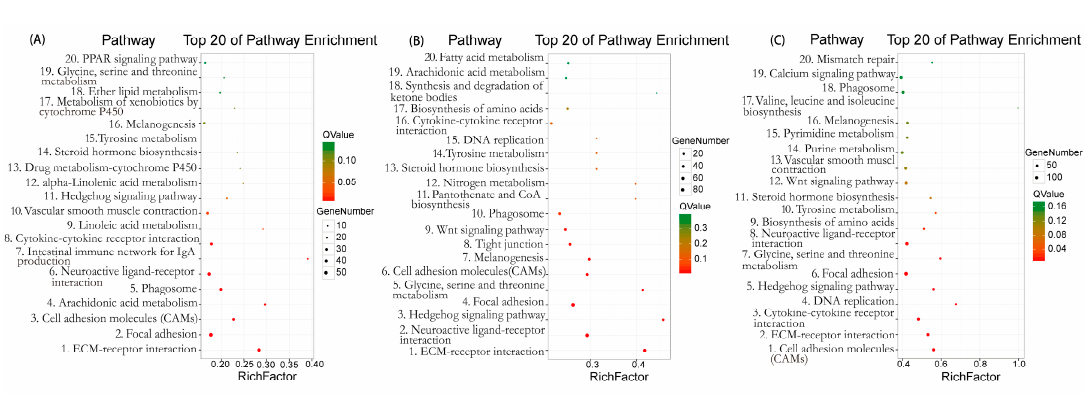
Figure 4. Top 20 pathway enrichment in Kyoto Encyclopedia of Genes and Genomes (KEGG) pathway analysis. ( A ) E13 vs. E18. ( B ) E18 vs. E28. ( C ) E13 vs. E28. The greater the Rich Factor, the higher the degree of enrichment. The Q value ranges from 0 to 1 and the closer it is to zero, the more significant the enrichment.